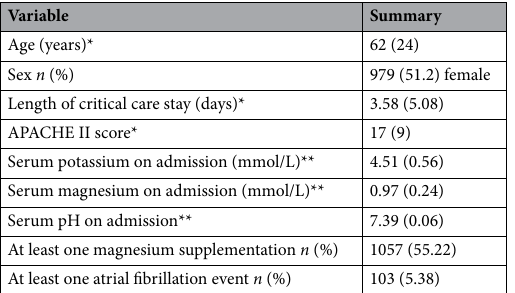
Table 1. Summary of study population. *Non-normally distributed variables described using median (interquartile range). **Normally distributed variables described using mean (standard